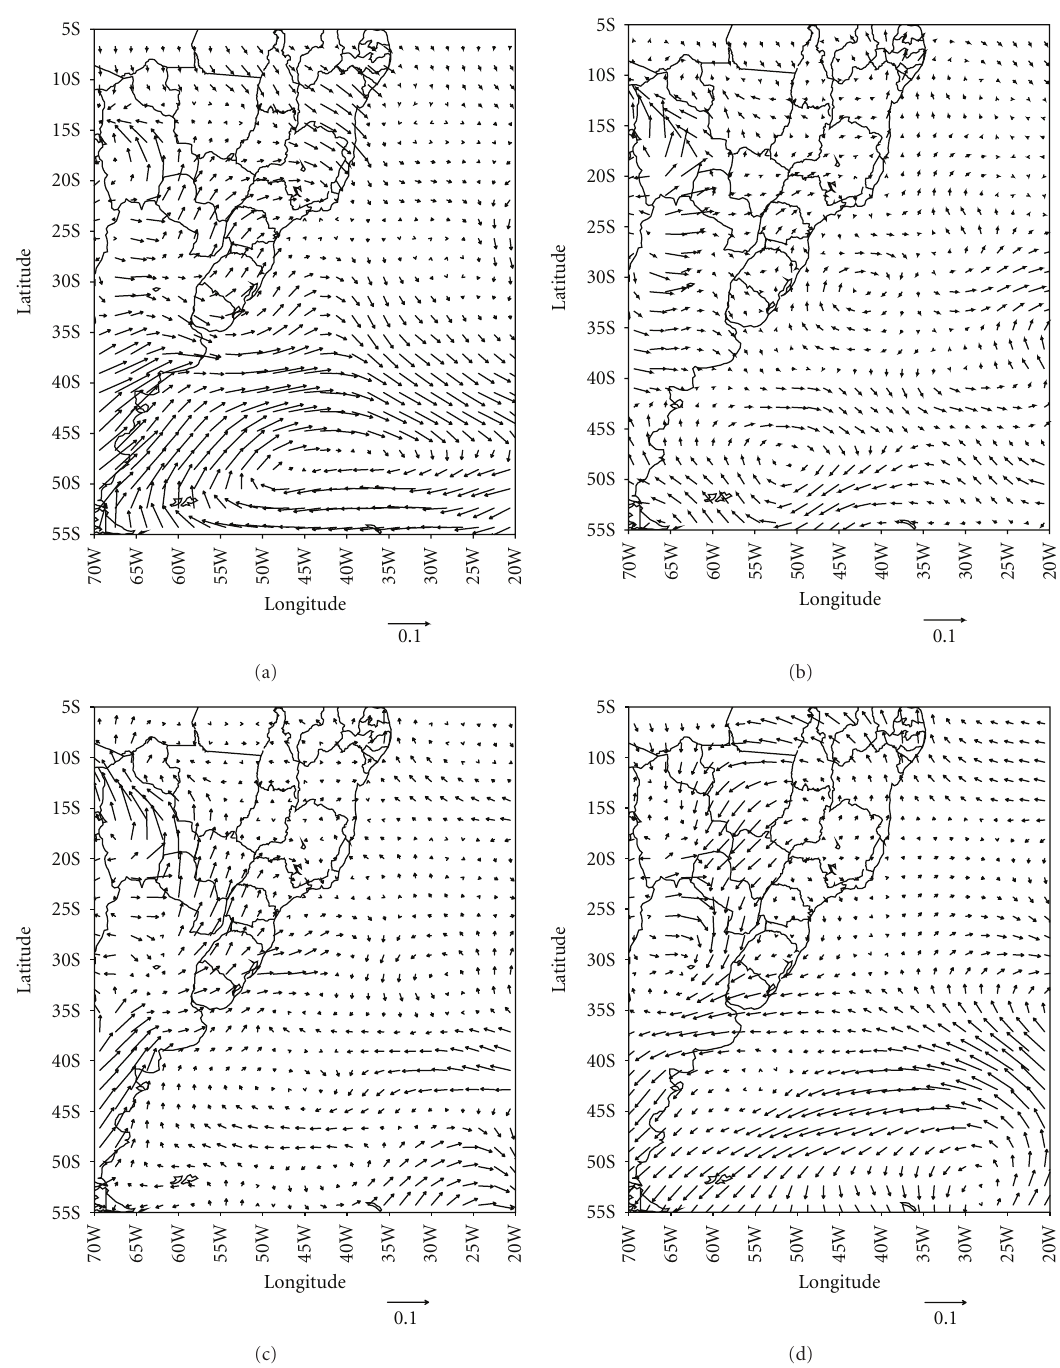
Figure 3: Wind anomaly from NCEP/NCAR reanalysis relative to the mean from 1998 to 2008 for (a) April, (b) May, (c) June, and (d) July.